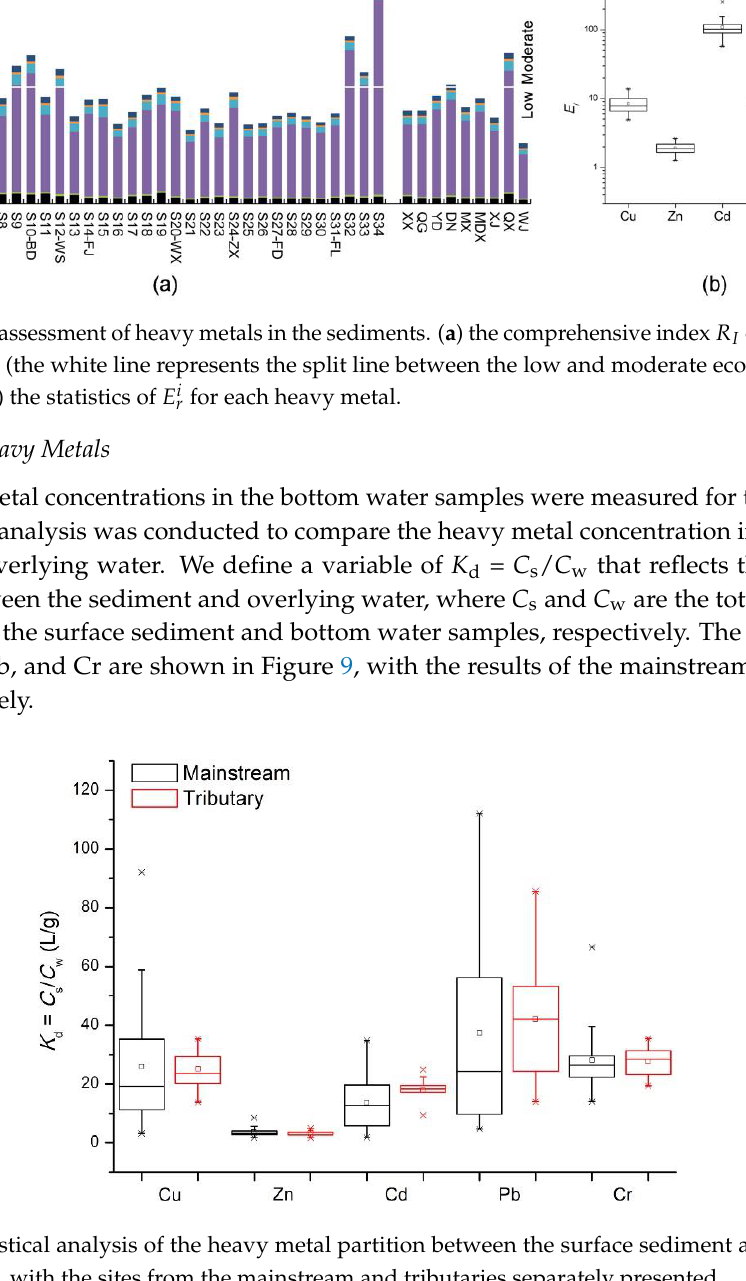
Figure 10. Redundancy analysis (RDA) analysis results of the K d values and environment variables. 5. Conclusions Heavy metals exert significant negative impacts on the aqueous environment due to their abundance, persistence and toxicity. The reservoir operation affects the distribution of heavy metals through changing the hydraulic regime of natural rivers, and causing sediment sorting and deposition in the reservoir, which leads to variations in water depth, median sediment size, dissolved oxygen and other environmental variables. In this study, the spatial distribution and